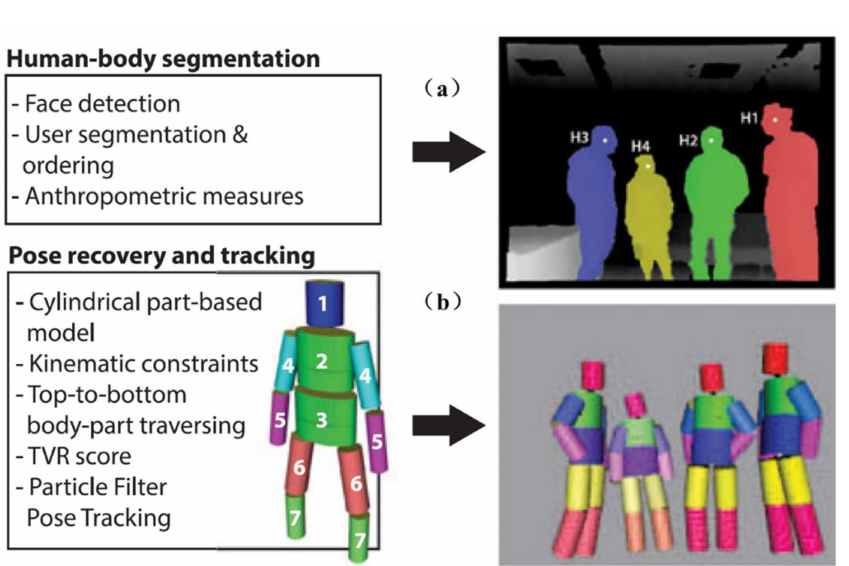
Figure 5. A geometric model can be applied to human joint estimation. ( a ) includes the human body segmentation and depth-based ordering and ( b ) includes the pose recovery and tracking. Figure from